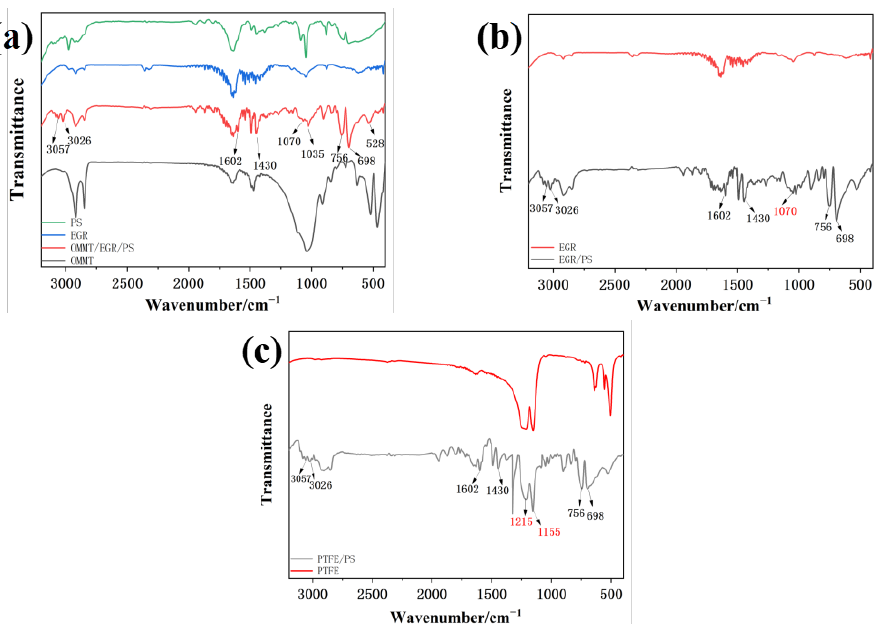
Figure 3. FTIR spectra of ( a ) OMMT/EGR/PS and PS, ( b ) EGR/PS, ( c ) PTFE/PS.